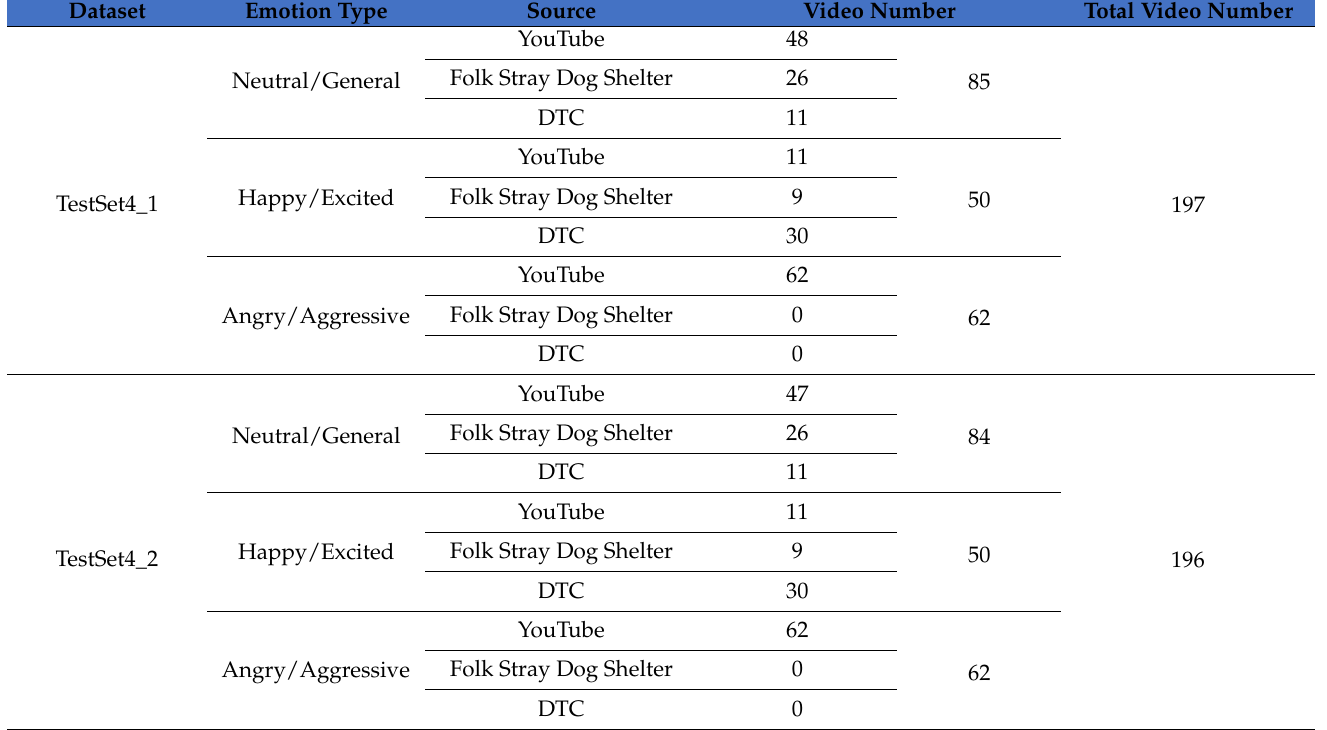
Table 8. Test data-set for the dog emotion recognition